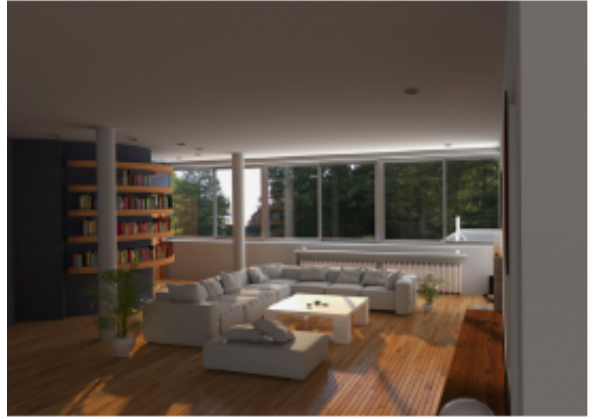
Figure 17. Rendering of the same room